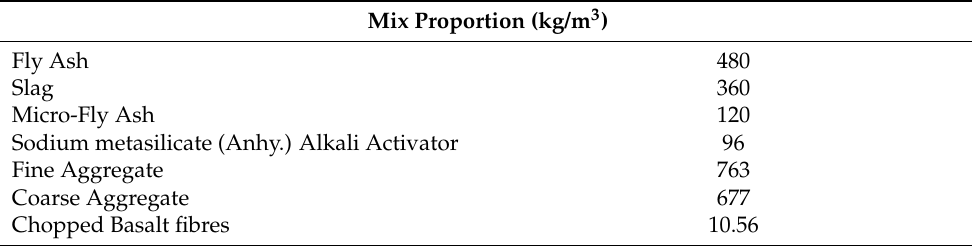
Table 1. Mix proportion of self-compacting geopolymer concrete along with chopped basalt fibre content.